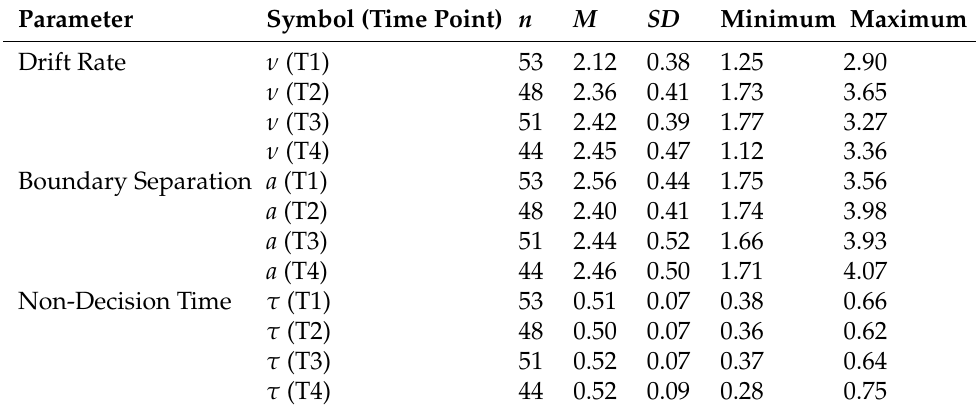
Table A6. Summary statistics of the individual diffusion model parameter estimates for each time point for Group 5.